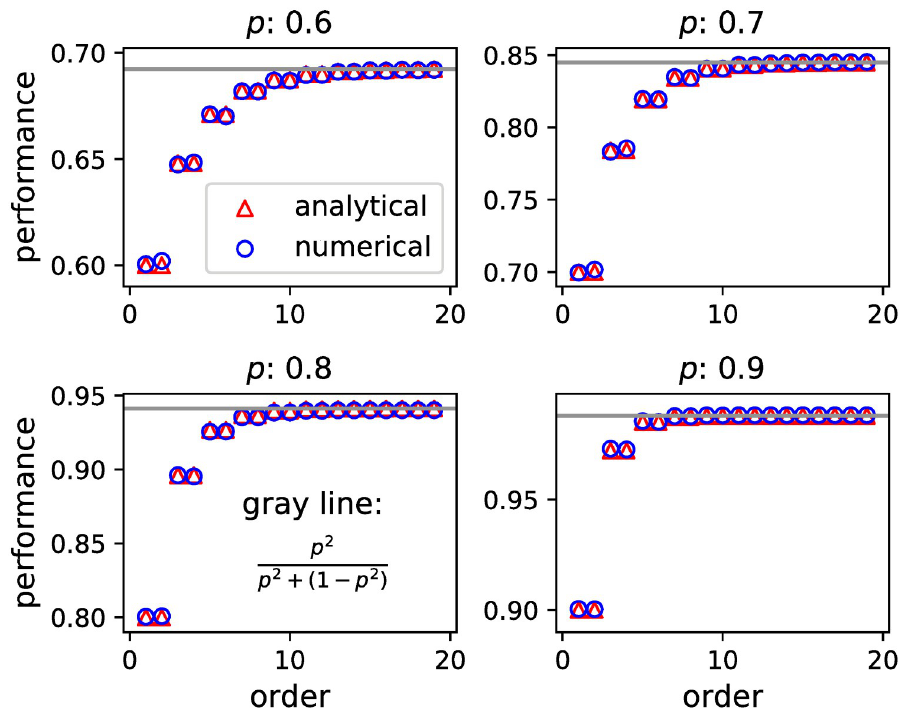
Fig 4. Mean performance versus order. Simulation (blue circles) and analytical (red triangles) results of mean performance E[ π n ] (ordinate) versus order n (abscissa) are exhibited for each individual ability p in each panel. The horizontal grey line shows the value of π max ( p ).